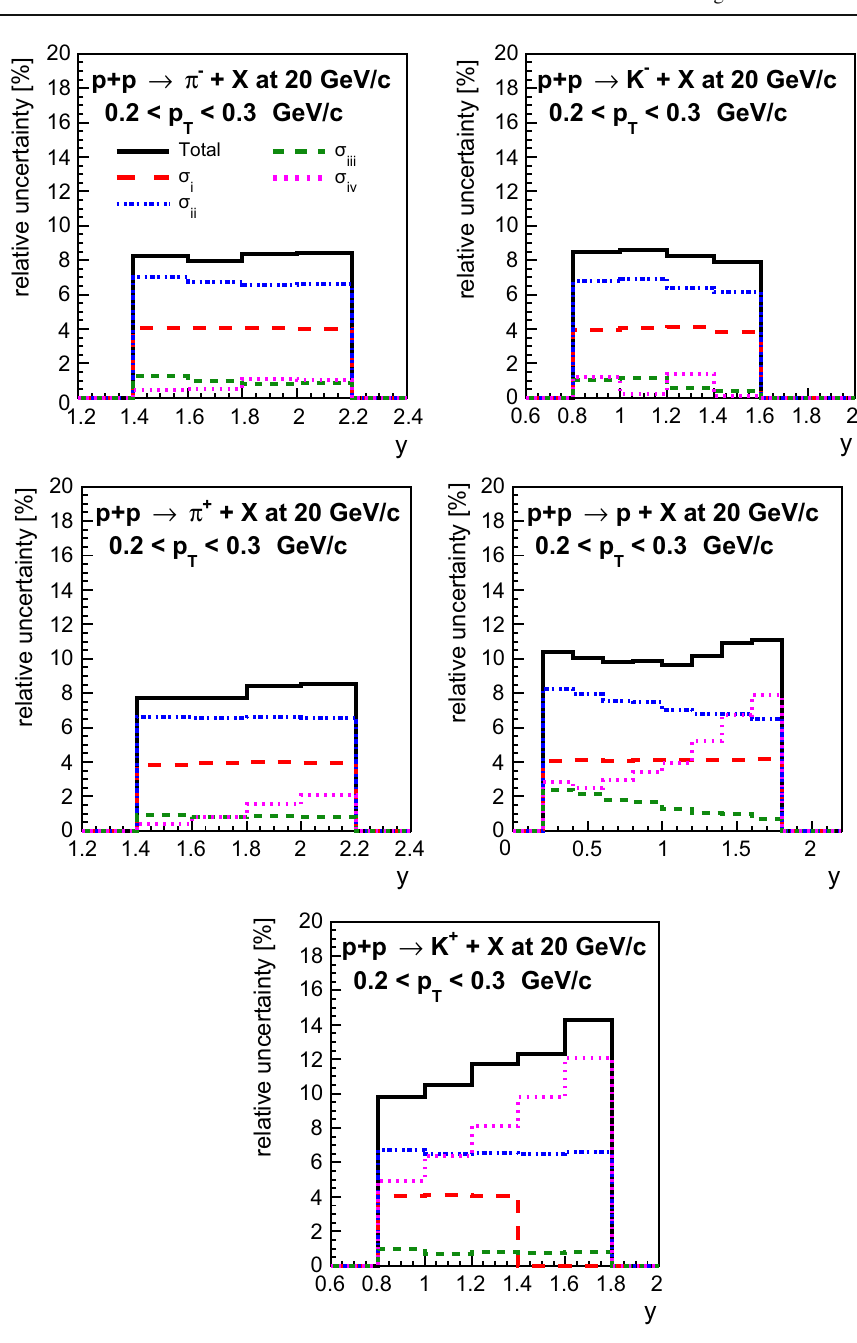
Fig. 16 Components of systematic uncertainty of particle spectra obtained from the d E / d x method in inelastic p + p interaction at 20 GeV / c as function of rapidity for the transverse momentum interval between 0.2–0.3 GeV / c . σ i refers to acceptance of events with off-time beam tracks, σ ii to possible bias of the S4 trigger, σ iii to event vertex and track selection procedure and σ iv to the identification technique. Black lines (Total) show the total systematic uncertainty calculated as the square root of the sum of squares of the